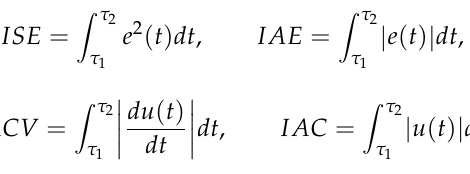
( β ∗ ) (42) for 0 LSOD